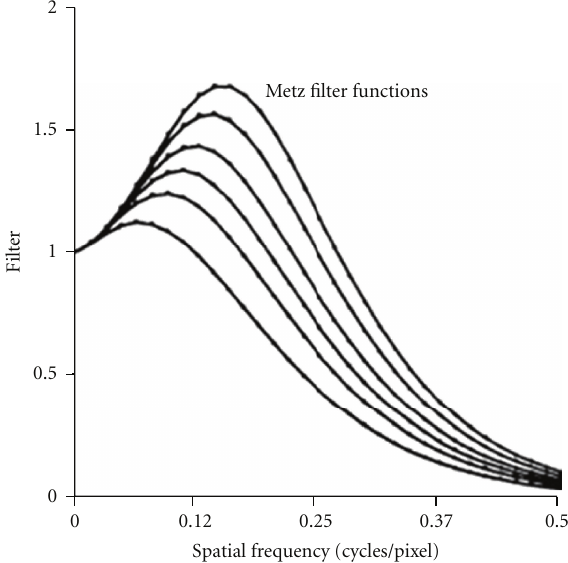
Figure 7: Plot of Metz filter for total counts of 20.000, 50.000, 100.000, 200.000, 500.000, and 1 million counts from lowest to highest curve [10].